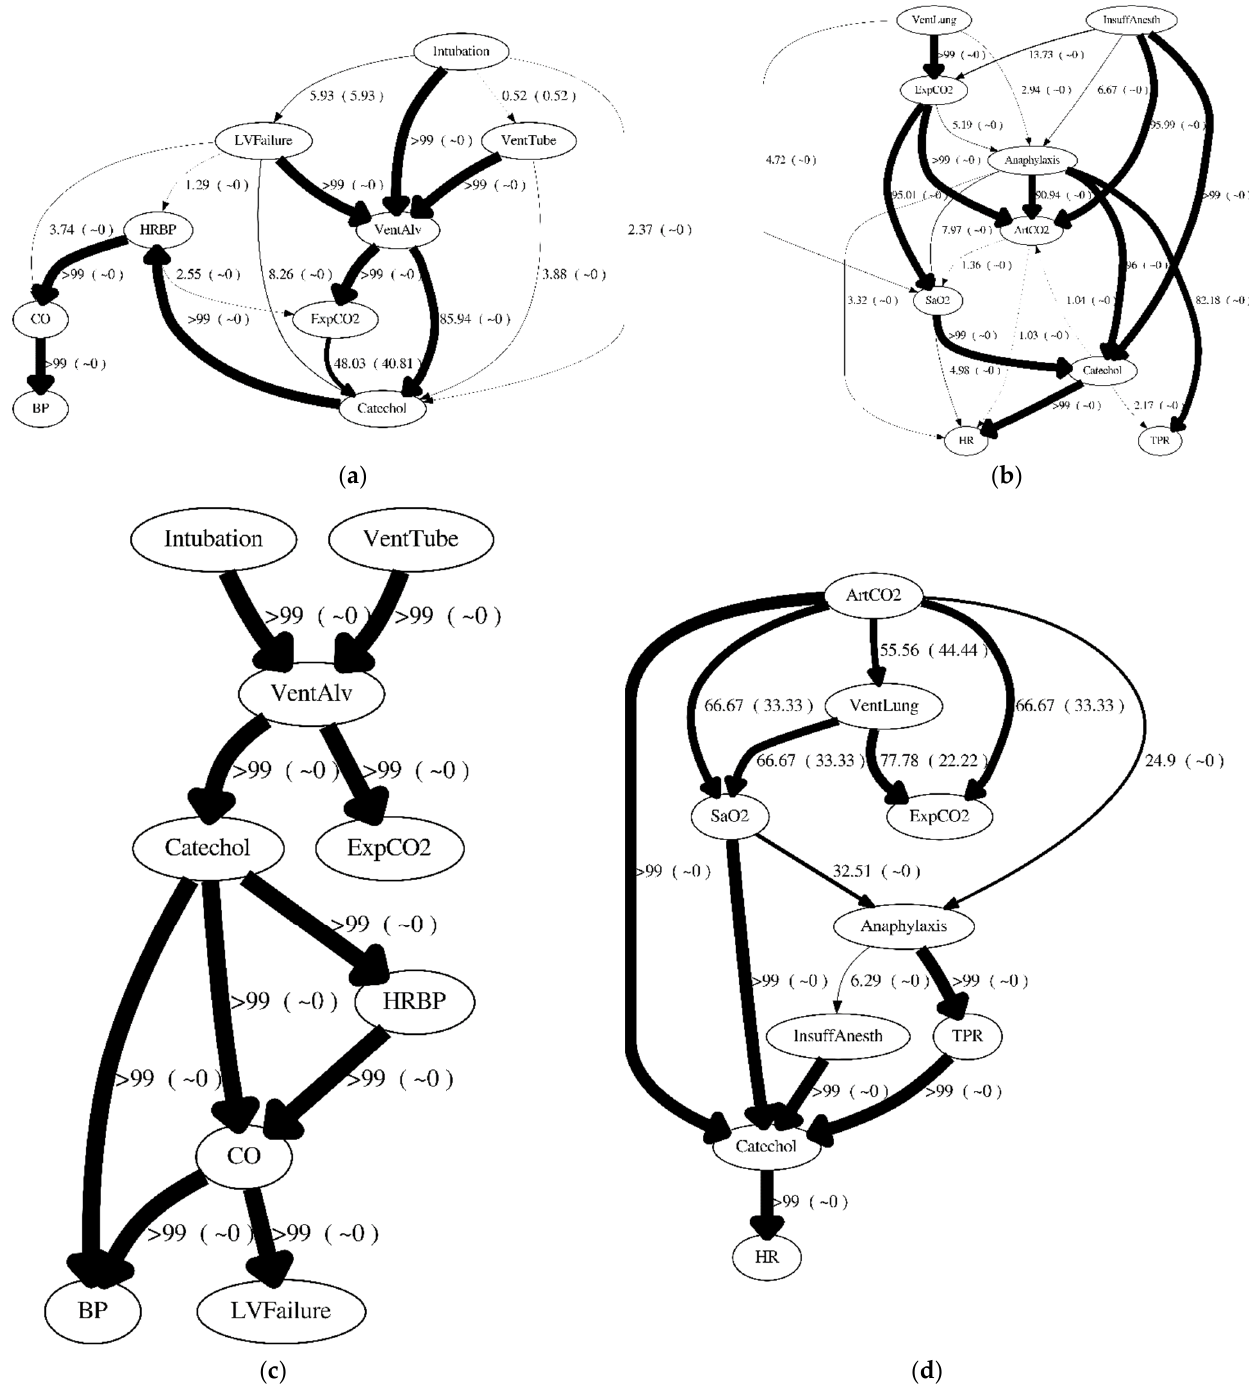
Figure 8. Consensus structure with the order weight for ( a ) D50S9, ( b ) D50C9, ( c ) D1KS9, and ( d ) D1KC9. Thicknesses of the arcs are based on the pairwise causal relationship probability that is presented as a label in percentage (the reverse causal relationship probability is presented in the parentheses). >99 and ~0 represent pairwise causal relationship probability greater than 0.9999 and less than 0.0001 respectively.